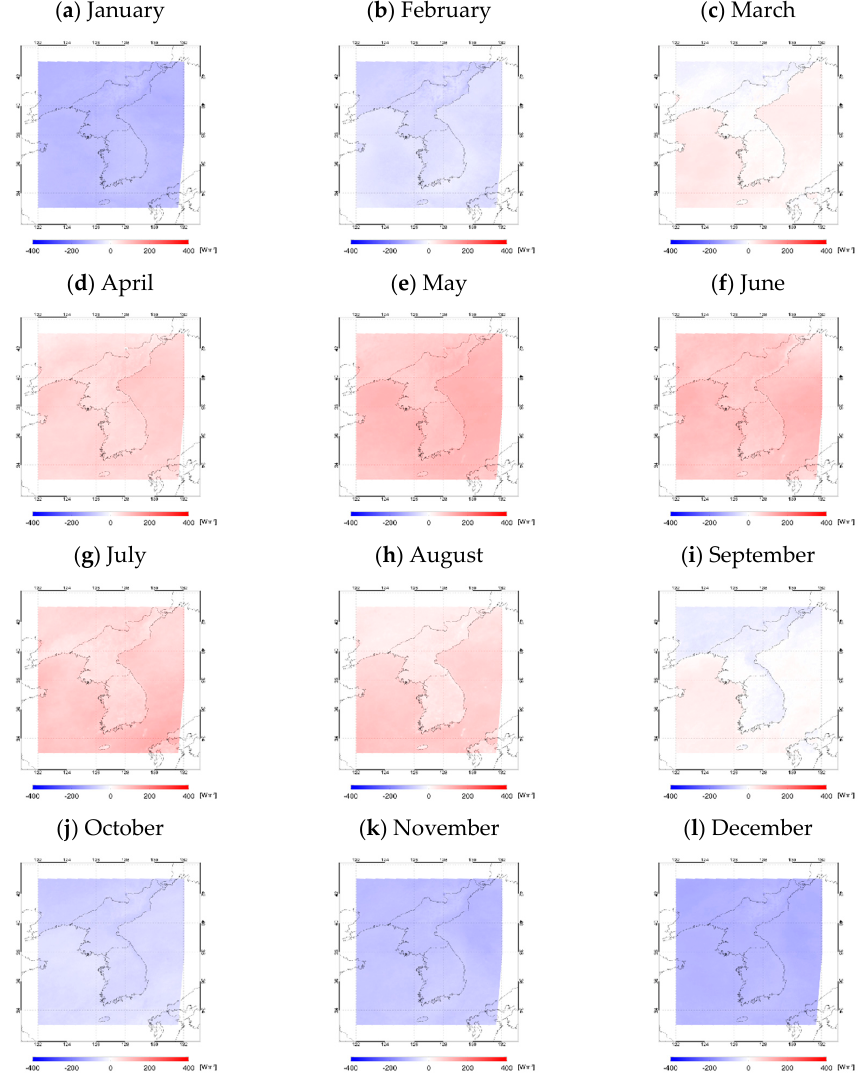
Figure 12. Distribution of monthly mean energy budget ( R T ) at the top of the atmosphere for the Korean Peninsula region in 2016.